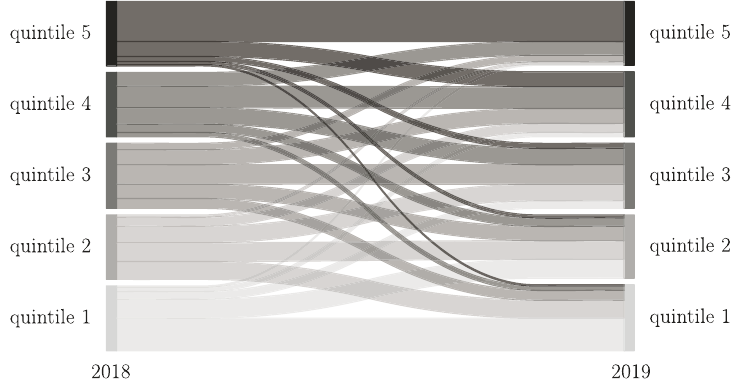
Figure 2: Flow of hospitals between quintiles of TPS in 2018 –